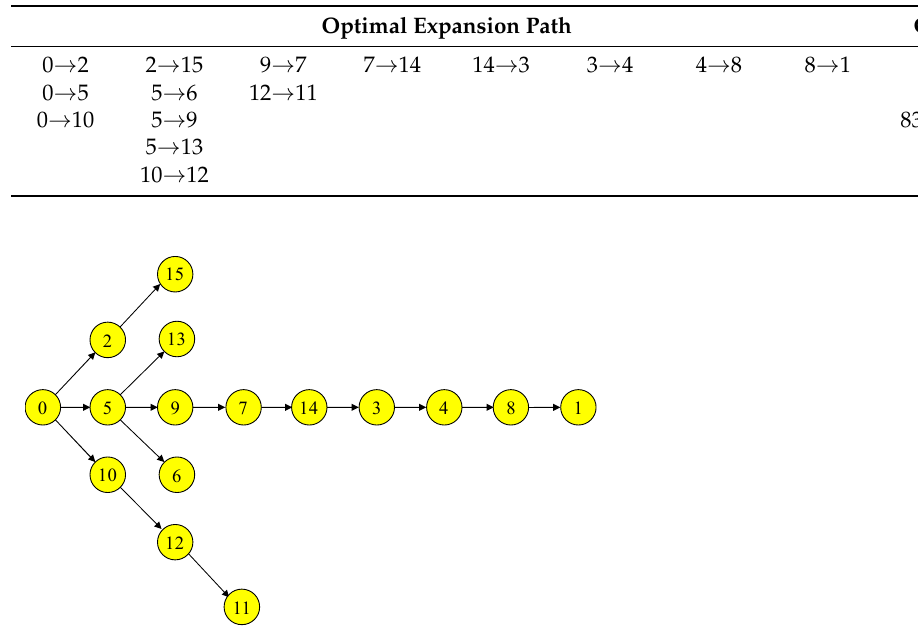
Figure 4. The minimum spanning tree for silicon intellectual property (SIP) development of design service company X.